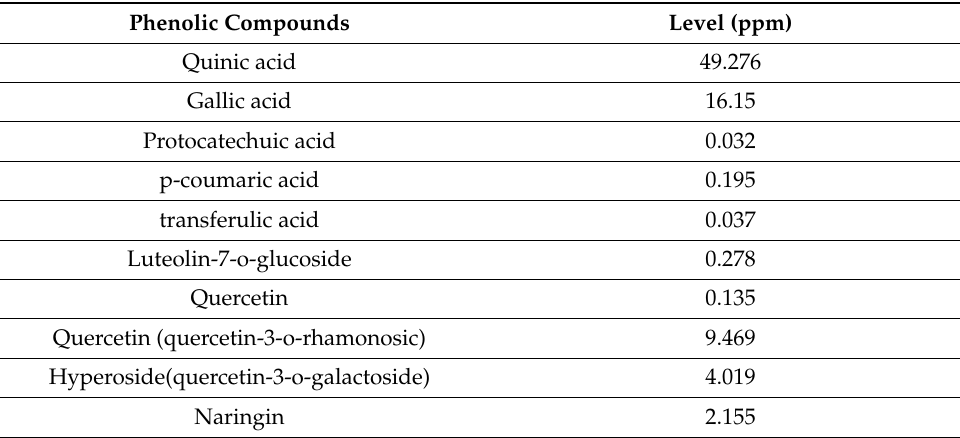
Table 2. Identification and quantification of the phenolic compounds by